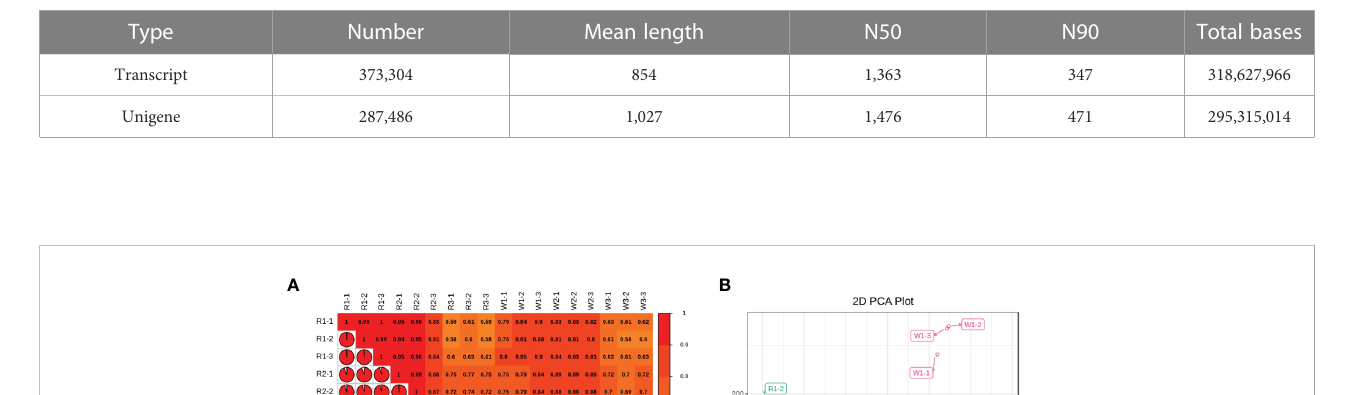
TABLE 2 Genome sequencing, assembly, and quality assessment in nut fl owers.